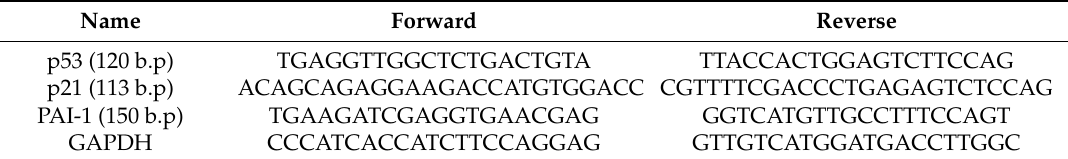
Table 2. Primer sets used for real-time